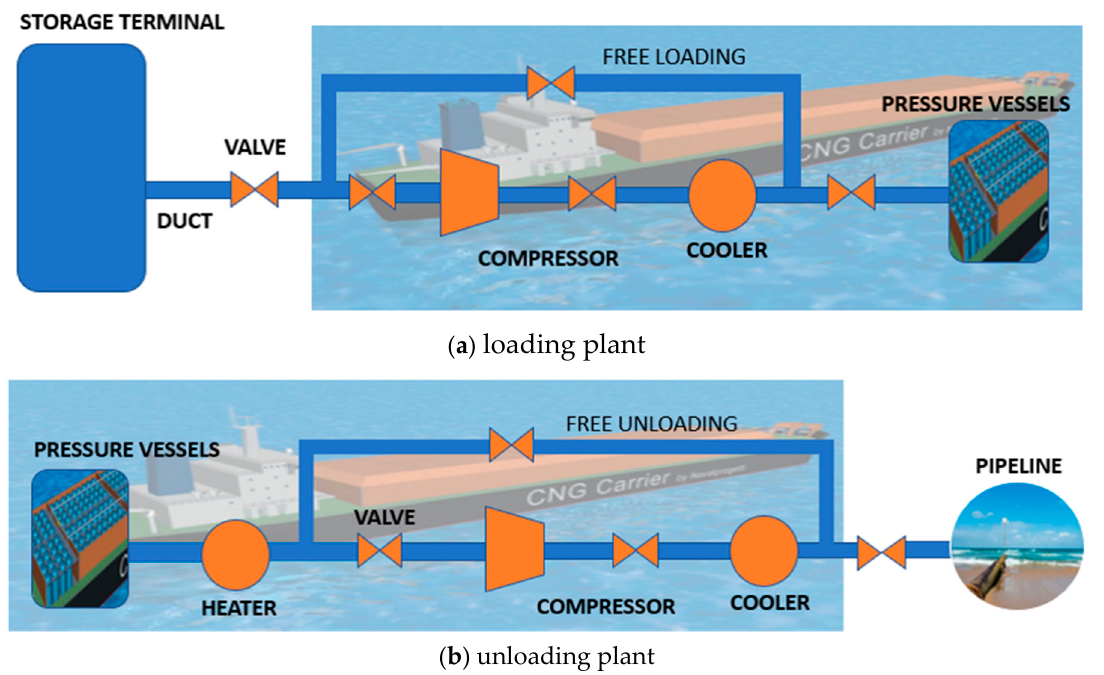
Figure 1. Schematic of the loading ( a ), and unloading ( b ), CNG plants.